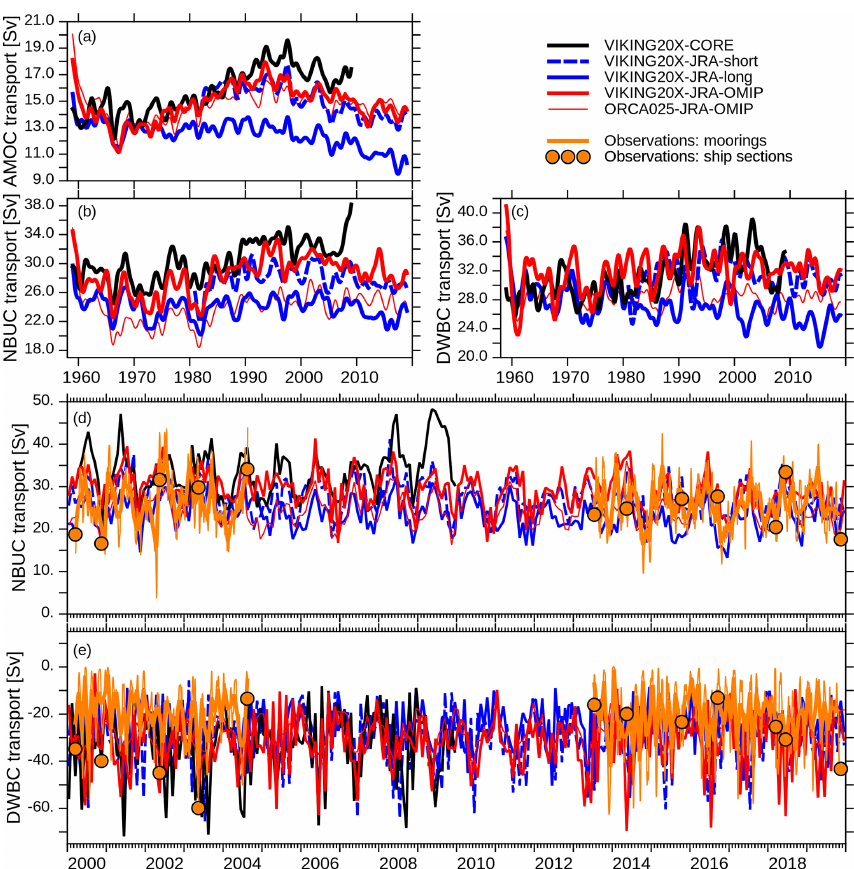
Figure 17. Time series of interannually filtered (a) AMOC, (b) NBUC and (c) DWBC transports at 11 ◦ S; monthly averages of positive (north-northeastward) NBUC and negative (south-southwestward) DWBC transports (see Table 7 for details of the definitions) are given in (d) and (e) together with mooring-based (orange curves; thick monthly, thin 2.5d averages) and ship-based observations (orange